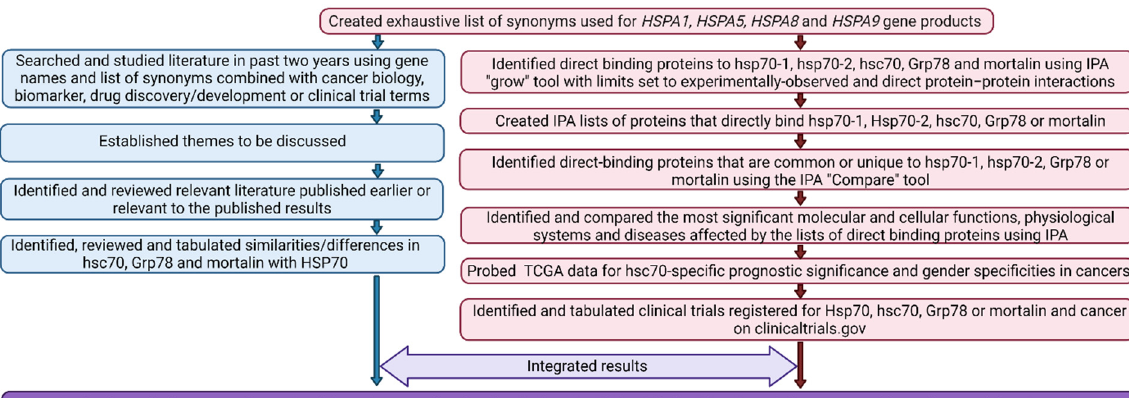
Figure 1. Methodologic approach.